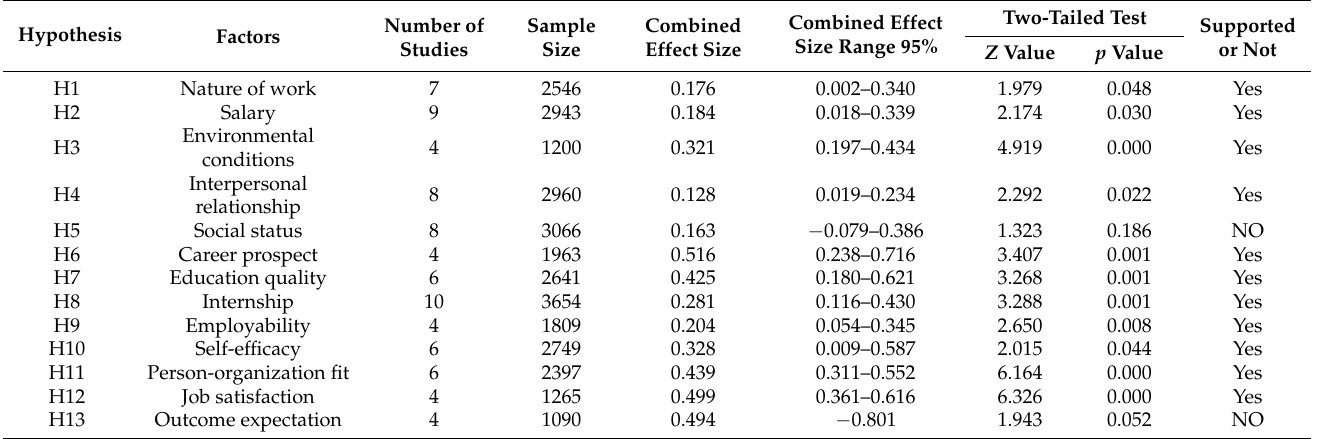
Table 3. Results of random-effects model